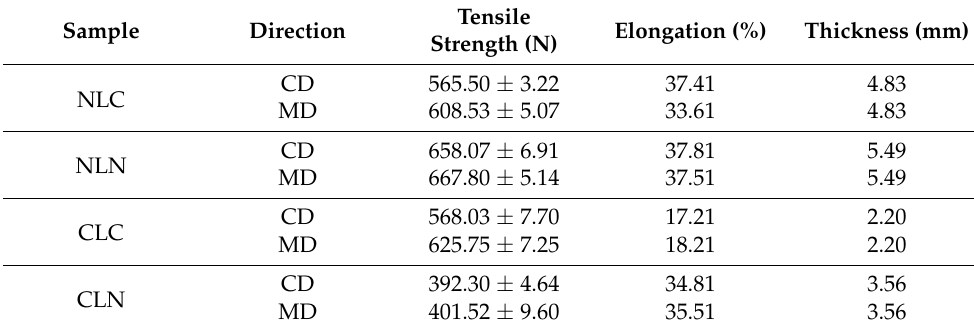
Figure 4. Tearing strengths of the NLC, NLN, CLC, and CLN composites. Table 2. Tearing